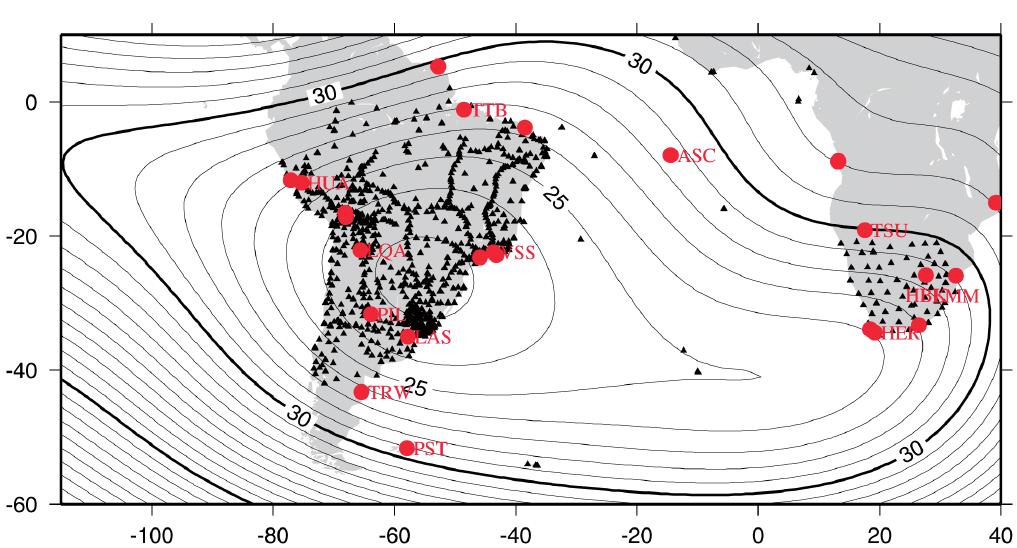
Fig. 4. Locations of observatories (red circles), repeat stations and survey sites (black triangles) where a total intensity of less than 30 µ T has been observed. Field intensity ( µ T) for 2005.0 from IGRF-10 also